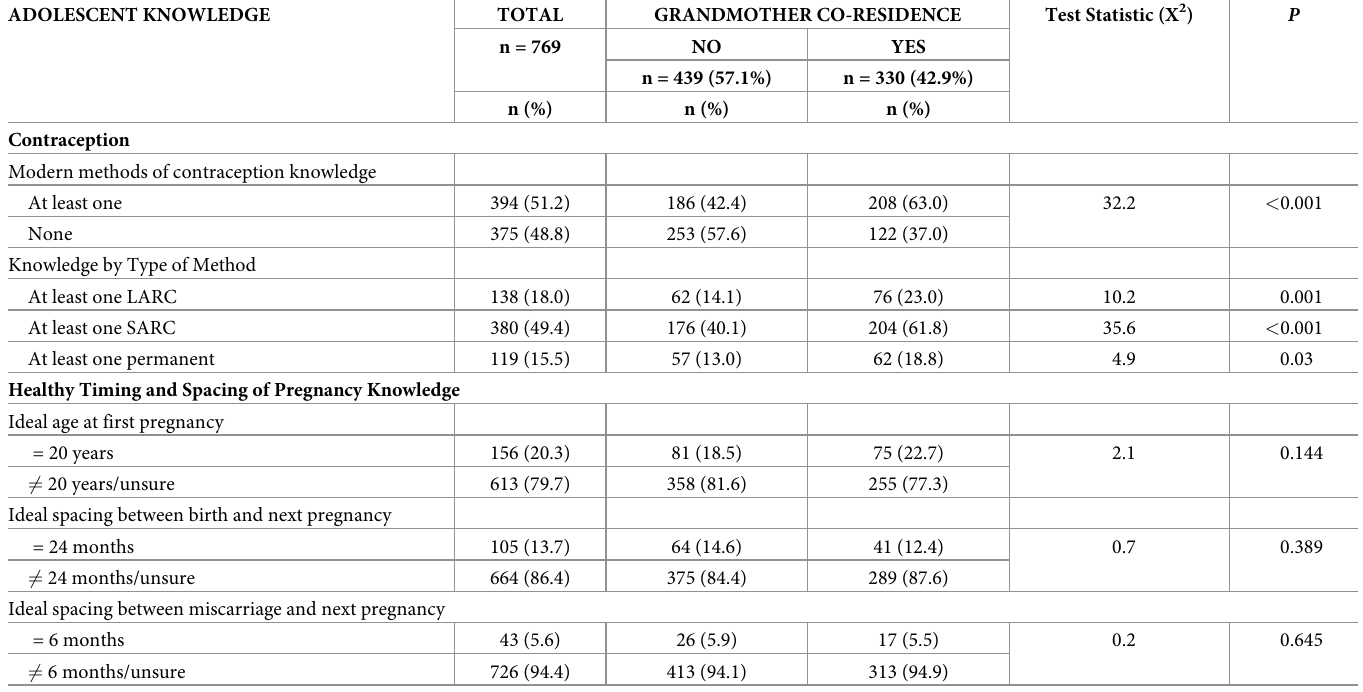
first pregnancy (27.5% versus 17.8%) compared to adolescents who live with a grandmother without correct knowledge. Grandmothers’ correct knowledge around the other two main FP knowledge questions (spacing between birth and miscarriage and next pregnancy) were not significantly associated with differences in adolescent knowledge. To mitigate data sparsity issues and avoid biasing parameter estimates, some data fields were combined. The two highest equity quintiles were collapsed and combined into the second Table 2. Adolescent FP knowledge stratified by grandmother residency